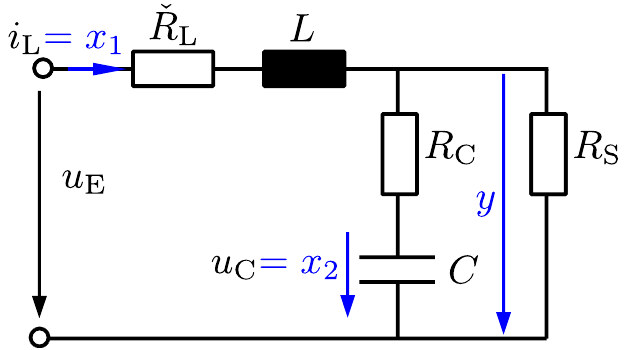
Figure 2. Simplified model of an electrical